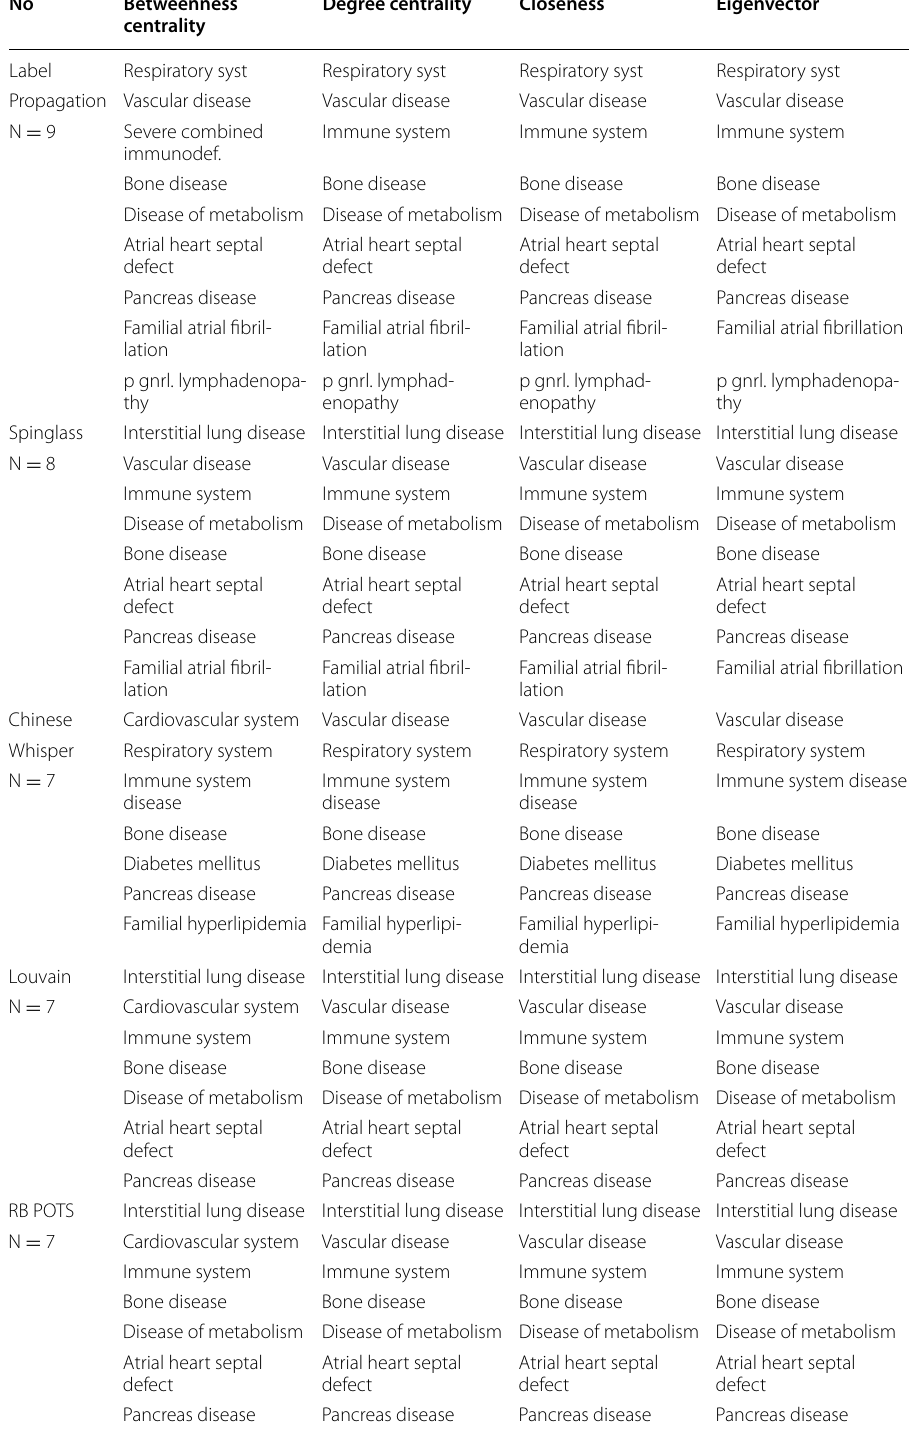
Table 5 List of significant diseases in each community, ordered according to nodes obtained from various centralities